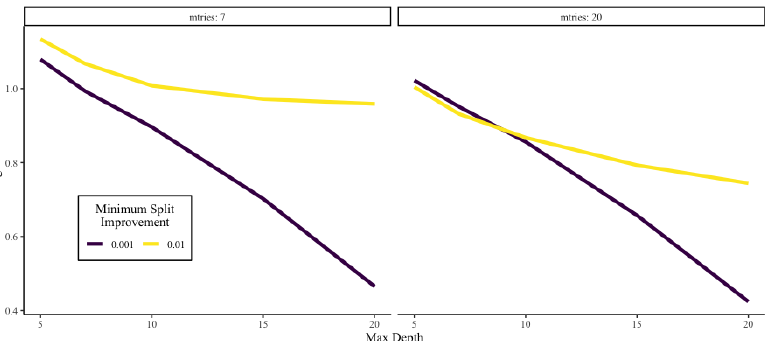
Figure 14. Visualization of the results from tuning random forests to predict claim frequency on the COLL data. Here, we show the change in logloss across different values of max depth of each tree in the random forest. The left pane shows the results when mtry is 7, and the right pane shows the results when mtry is 20. Each pane contains two lines of different colors representing different minimum split improvements.